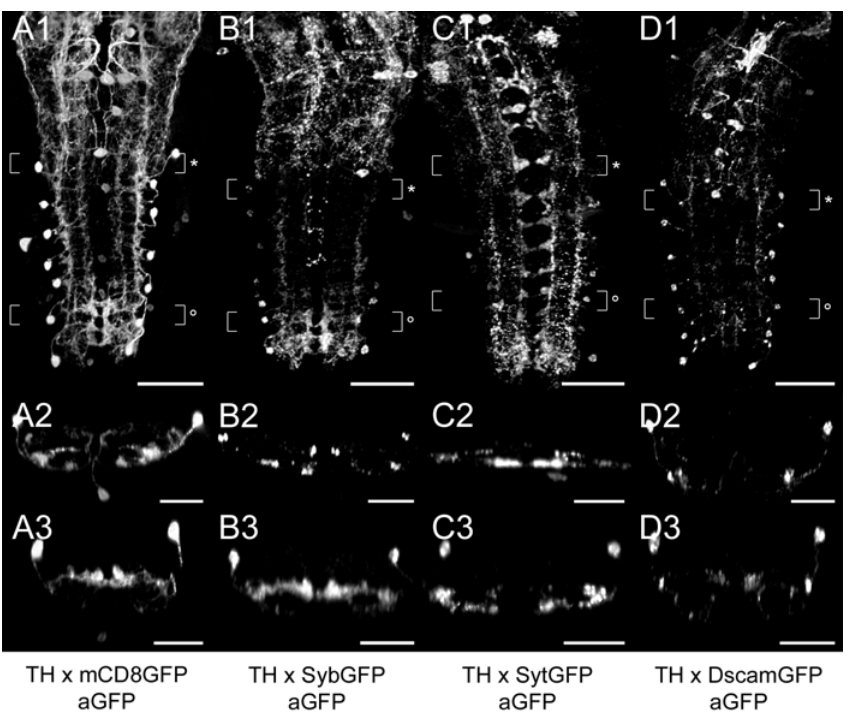
Figure 5. Distribution of ectopically expressed neuronal compartment markers in TH neurons. A1-D1) Dorsal view of GFP immunoreactivity in the VG of larvae expressing Th-gal4 -driven mCD8GFP (A1-3), SybGFP (B1-3), SytGFP (C1-3), or DscamGFP (D1-3). A2-D2) Corresponding transversal views of the neuromeres t3 or a1 (* in A1-D1). A3-D3) Additional transversal views showing the compartment marker distribution in a5/6 ( u in A1-D1). All images are auto-contrasted maximum pixel intensity projections of volume-rendered 3D image stacks. Scale bars: 50 m m in A1-D1), 25 m m in A2-D2) and A3-D3).